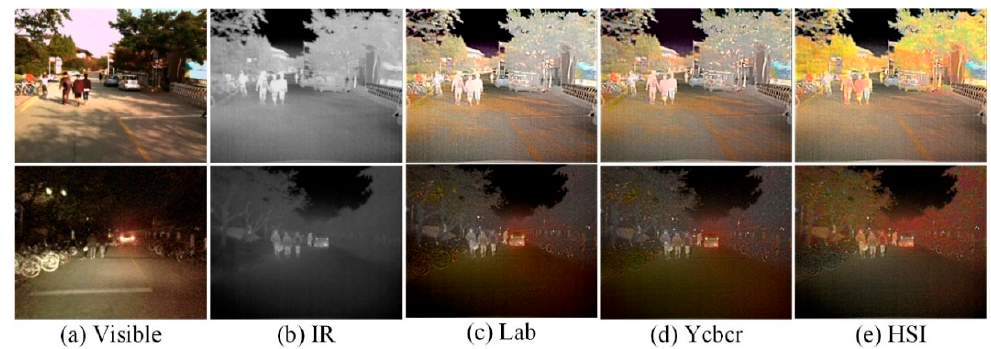
Figure 2. The fusion results via different color spaces. ( a ) shows the visible images; ( b ) shows the infrared images; ( c – e ) respectively show the fusion results based on Lab, Ycbcr and